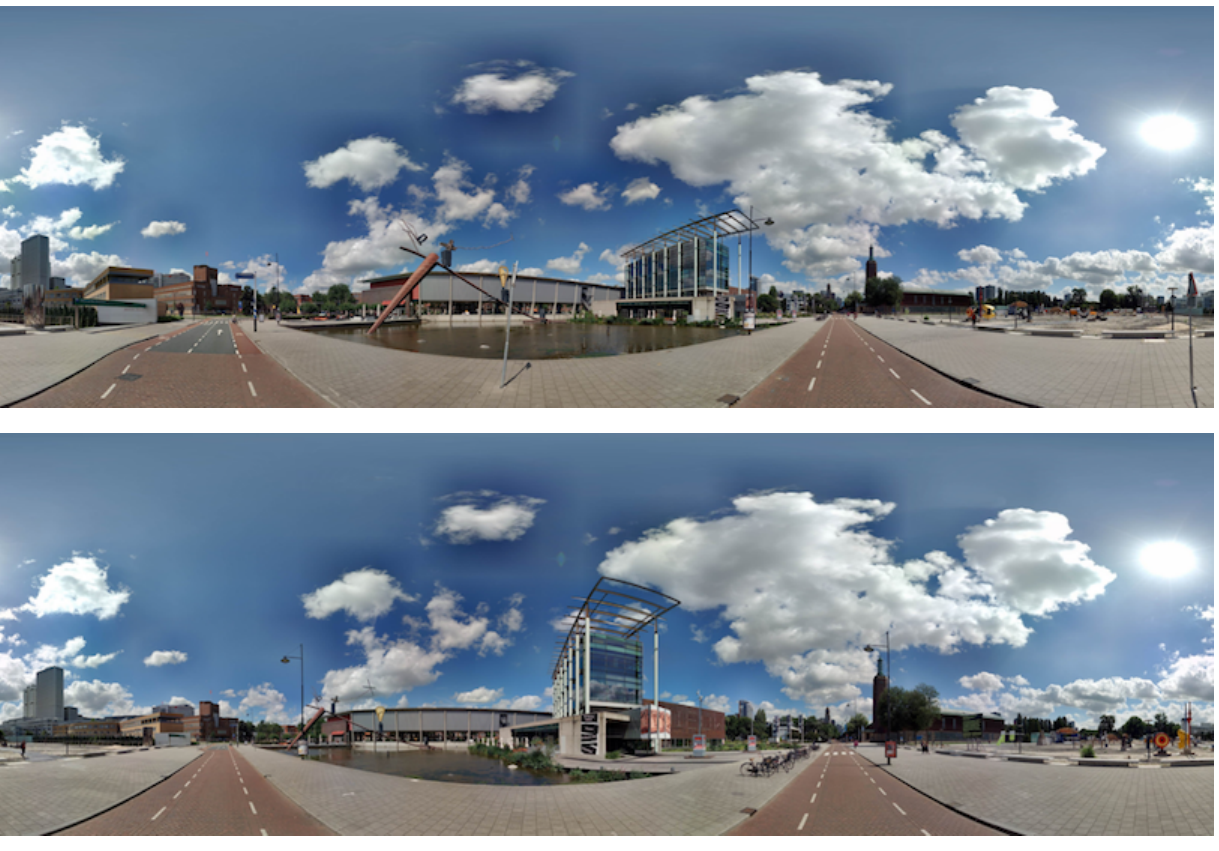
Figure 2. Two adjacent Mobile Mapping